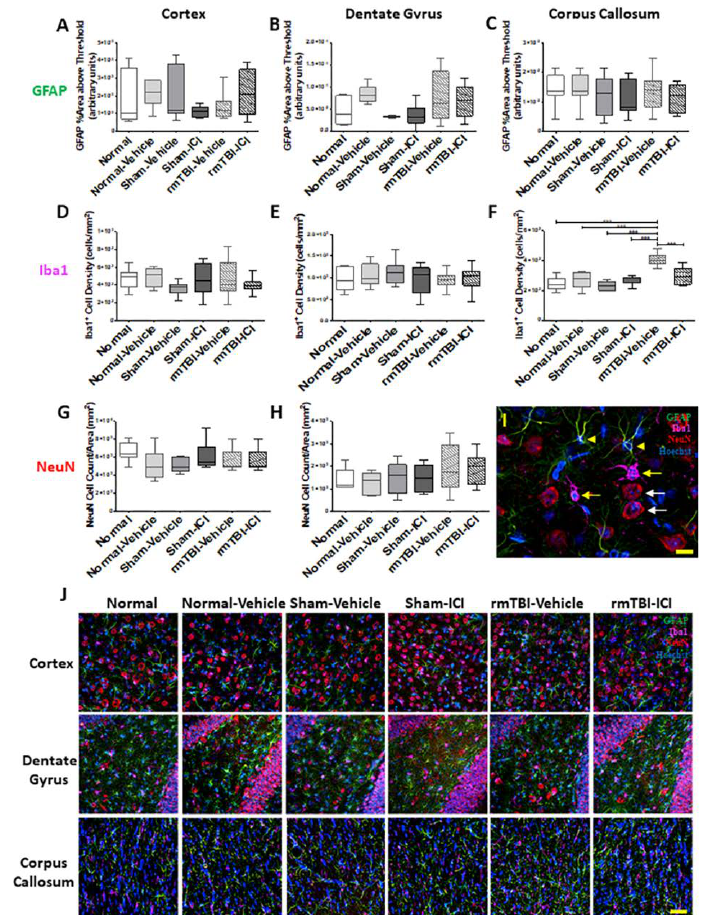
Figure 2. Cellular responses in the brain on day 11 following mTBI on days 1 and 2. ( A – C ) Percentage area above threshold of glial fibrillary acidic protein (GFAP) immunoreactivities, ( D – F ) Iba1 + cell densities, and ( G – H ) NeuN + cell densities are shown as median, interquartile range, and range in the middle cortex, the hilus of the dentate gyrus, and the splenium of the corpus callosum, respectively. Neuronal nuclear antigen (NeuN) positive cells were not observed in the corpus callosum. ( I ) Image of immunohistochemical staining at high magnification (600×) shows GFAP + (green) astrocytes (arrow head), Iba1 + (magenta) microglia (yellow arrow), and NeuN + (red) neurons (white arrow) co-localised with Hoechst (blue), respectively; scale bar = 20 μm. ( J ) Representative images of GFAP (green), Iba1 (magenta), and NeuN (red) immunohistochemical staining with Hoechst nuclear stain (blue); scale bar = 100 μm. *** p < 0.001, one-way analysis of variance with Bonferroni post-hoc comparisons.